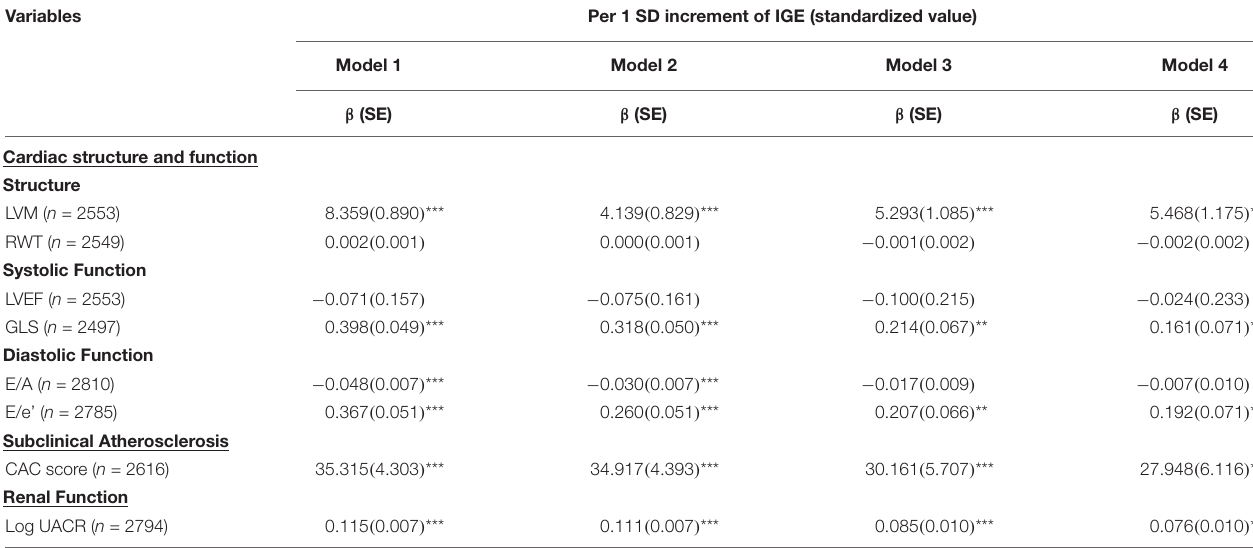
TABLE 2 | Linear regression models to examine the associations between intensity of glycemic exposure during young adulthood with target organ function in